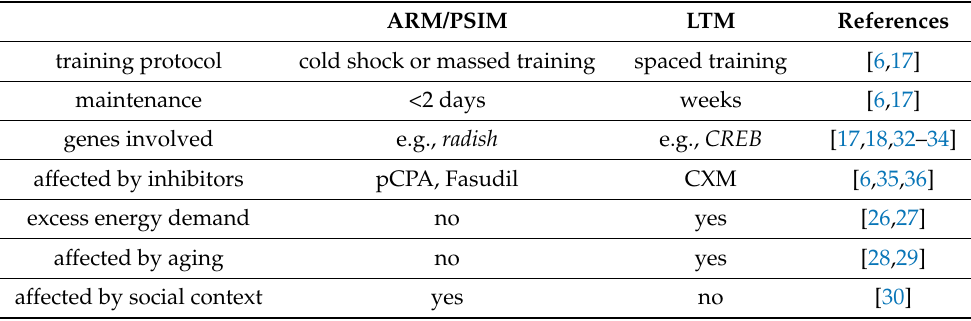
Table 1. Main differences between ARM/PSIM and